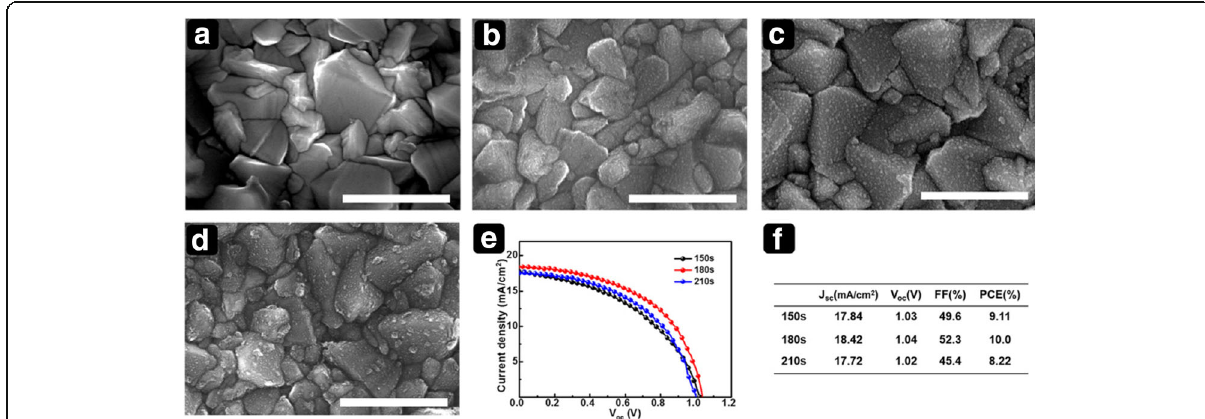
Fig. 3 Top-view SEM images of substrates for different deposition time. ( a ) Bare FTO and SnO 2 films deposited for ( b ) 150 s, ( c ) 180 s, and ( d ) 210 s. Corresponding photovoltaic performance: ( e ) J – V curves and ( f ) photovoltaic parameters of PSCs with electrodeposited SnO 2 ETL. Scale bar is 1 μ m